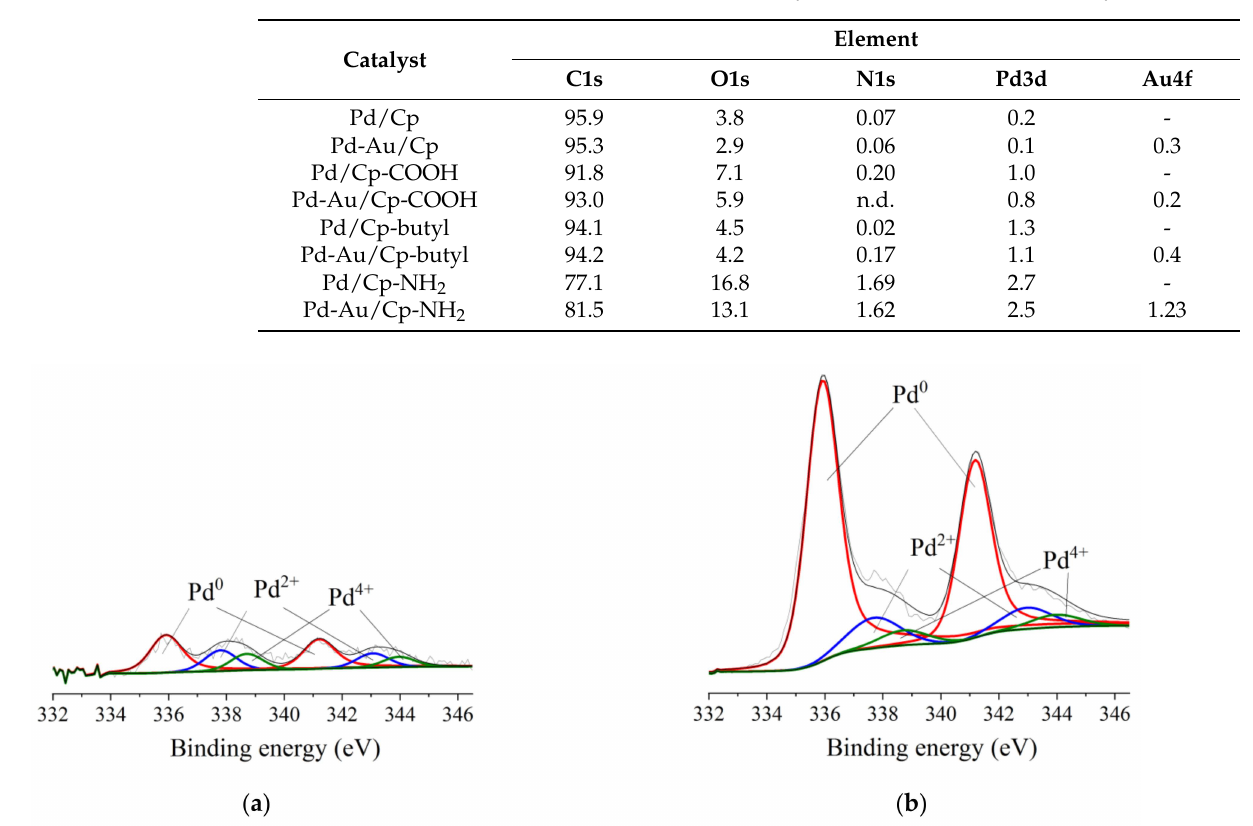
Table 6. Surface concentration of elements on the catalyst surface (at.%) determined by XPS.